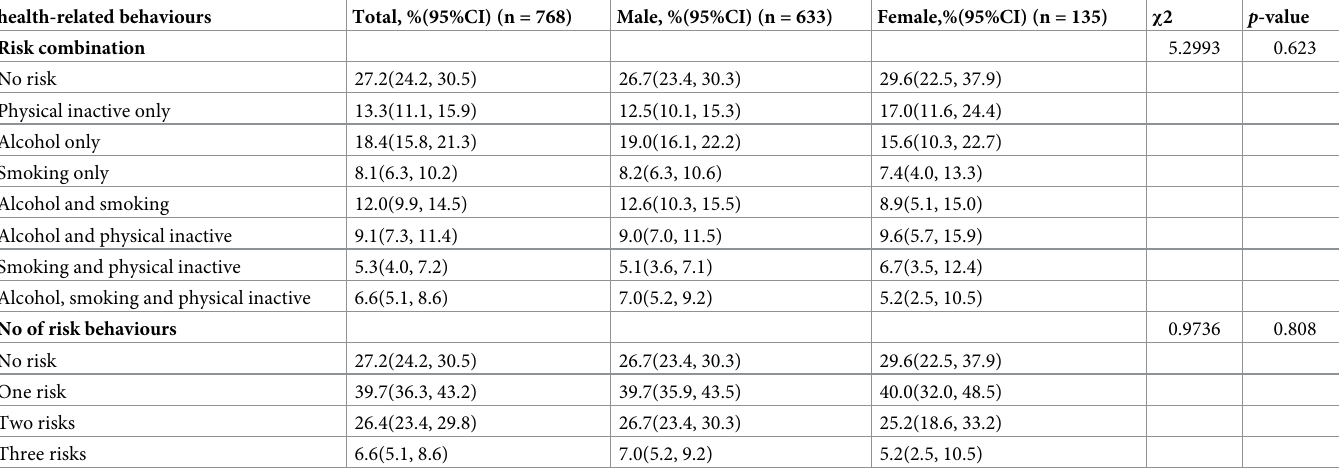
Table 2. Combination of risk behaviours across gender.